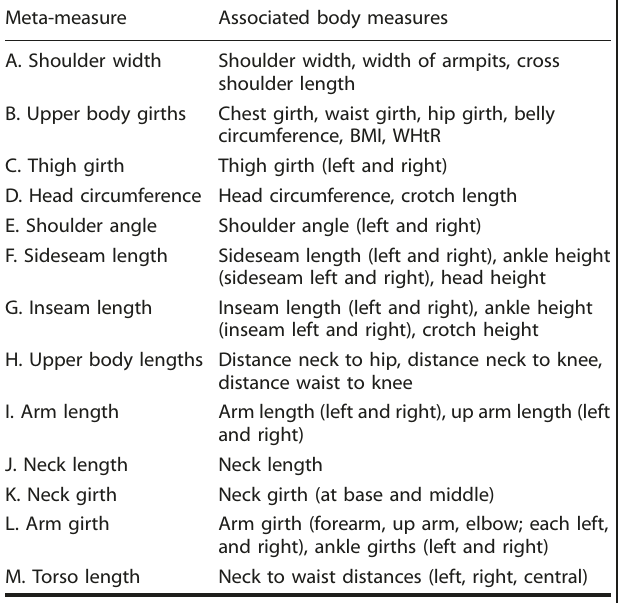
Meta-measures are labeled with capital